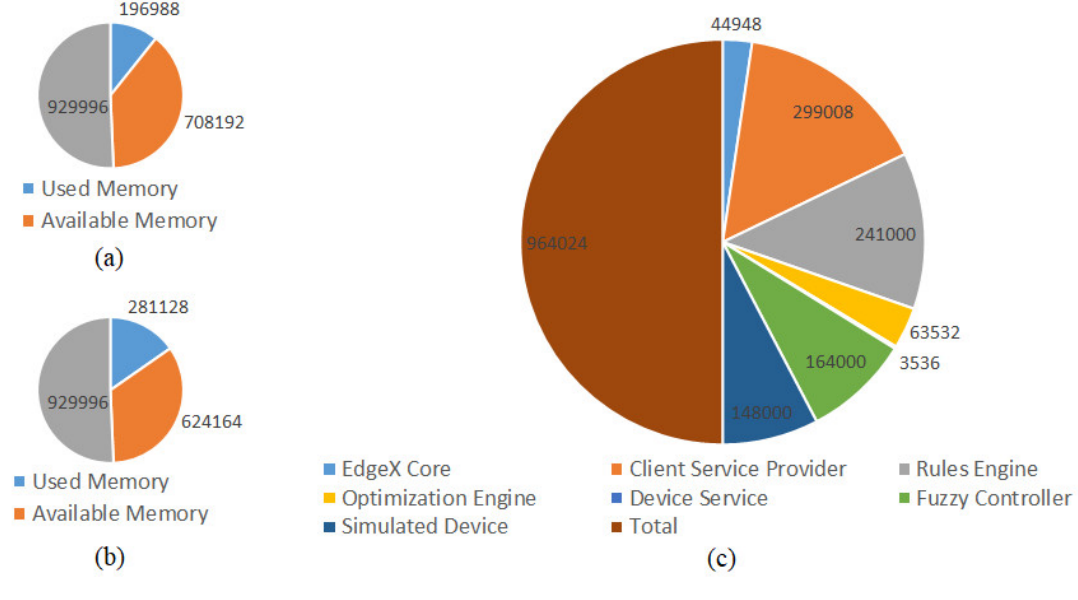
Figure 17. Proposed Microservices Memory Usage on Raspberry Pi 3. ( a ) A Raspberry Pi 3. ( b ) A Raspberry Pi 3. ( c ) Total Memory of